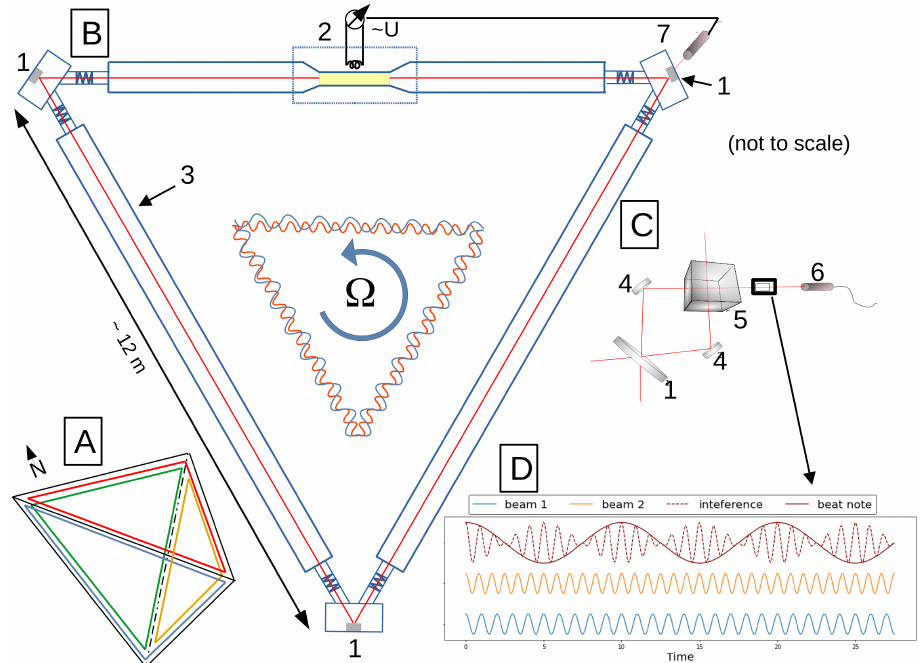
Figure 1. ( A ) all four components of ROMY form a downward pointing tetrahedron. ( B ) a schematic cutaway drawing of the design of one of ROMY’s components, each realized as an equilateral, triangular ring laser. (1) The triangular lasing path is closed using highly reflective mirrors. (2) gas discharge is sustained inductively with a radio antenna at the narrowed gain tube. (3) evacuated resonant cavity filled with a Helium-Neon mix. An illustration at the center shows the frequency shift between counter-propagating laser beams introduced by rotation Ω according to the Sagnac effect. ( C ) combination of the two beams using two deflection mirrors (4) and a beam combiner (5) is installed at the lower corner of the ring. A photo multiplier (7) records the monobeam intensity used to stabilize the laser intensity via a control loop.( D ) illustration of the interference (dashed red) of counter-propagating laser beams (blue and orange) with shifted frequencies which create the beat note (solid red) that is recorded by a photo multiplier